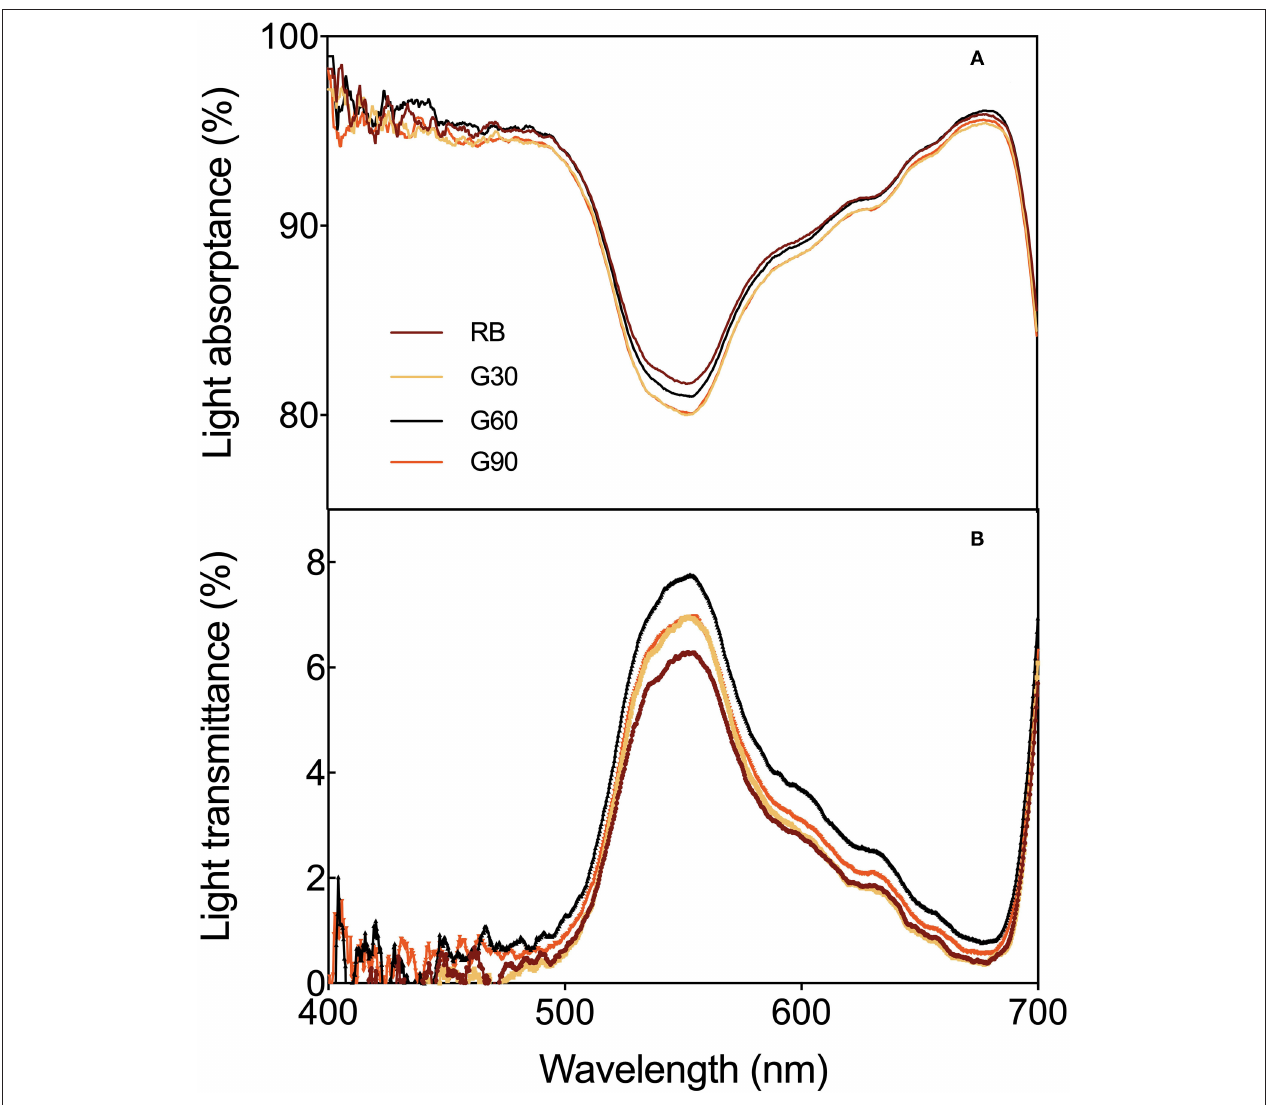
FIGURE 4 | Light absorptance (A) and light transmittance (B) as affected by the different proportions of green light.